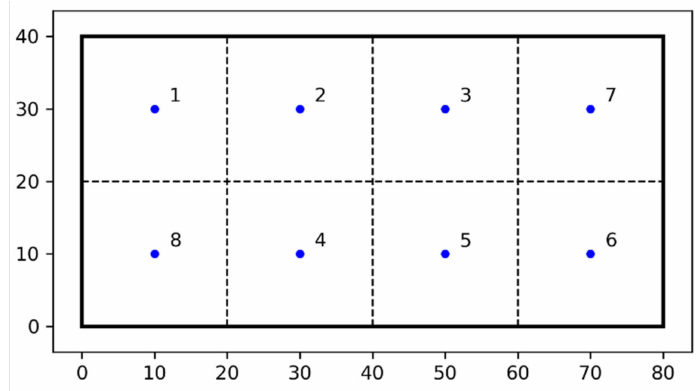
Figure 8. Map showing the locations of each store of the 8 firms.